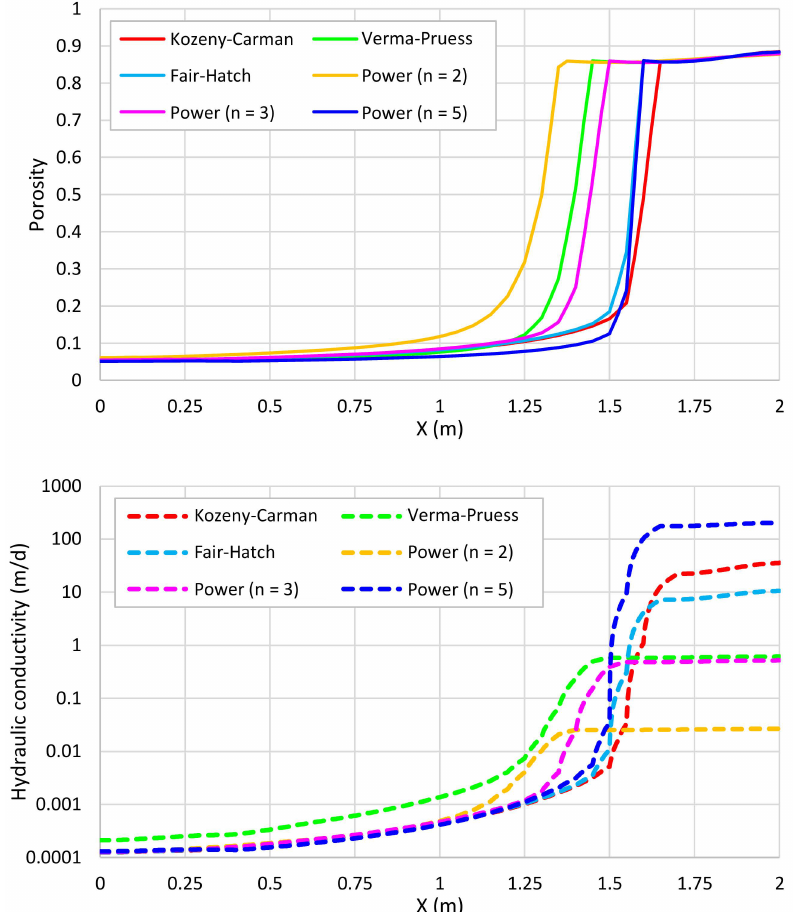
Figure 15. Computed porosity ( top ) and hydraulic conductivity ( bottom ) along the horizontal line at y = 1 m after 1000 years of simulation in scenario 1 by using several permeability-porosity